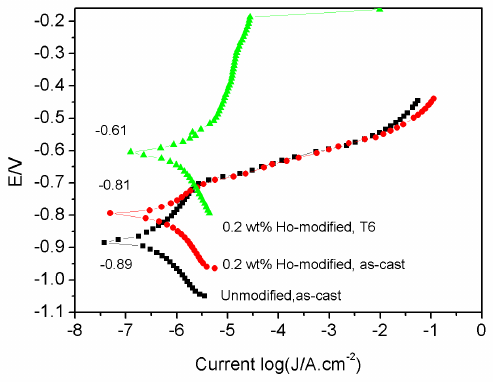
Figure 8. Potential polarization curves of the alloys in a 3.5 mol% NaCl solution.